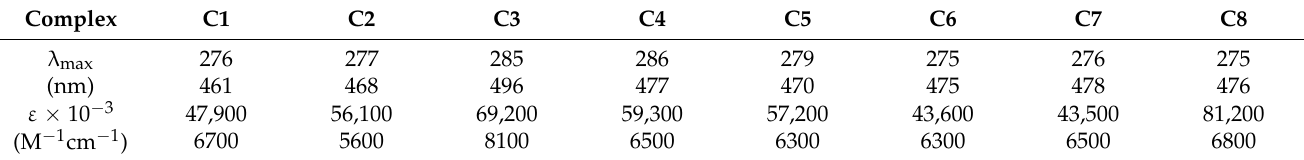
Figure 7. UV-Visible spectrum of C4 , with a zoom of the visible region. Table 6. Summary of electronic absorption properties of C1 – C8 (with two λ max values, one of which is the transition in the UV and the second in the visible region of the spectrum).